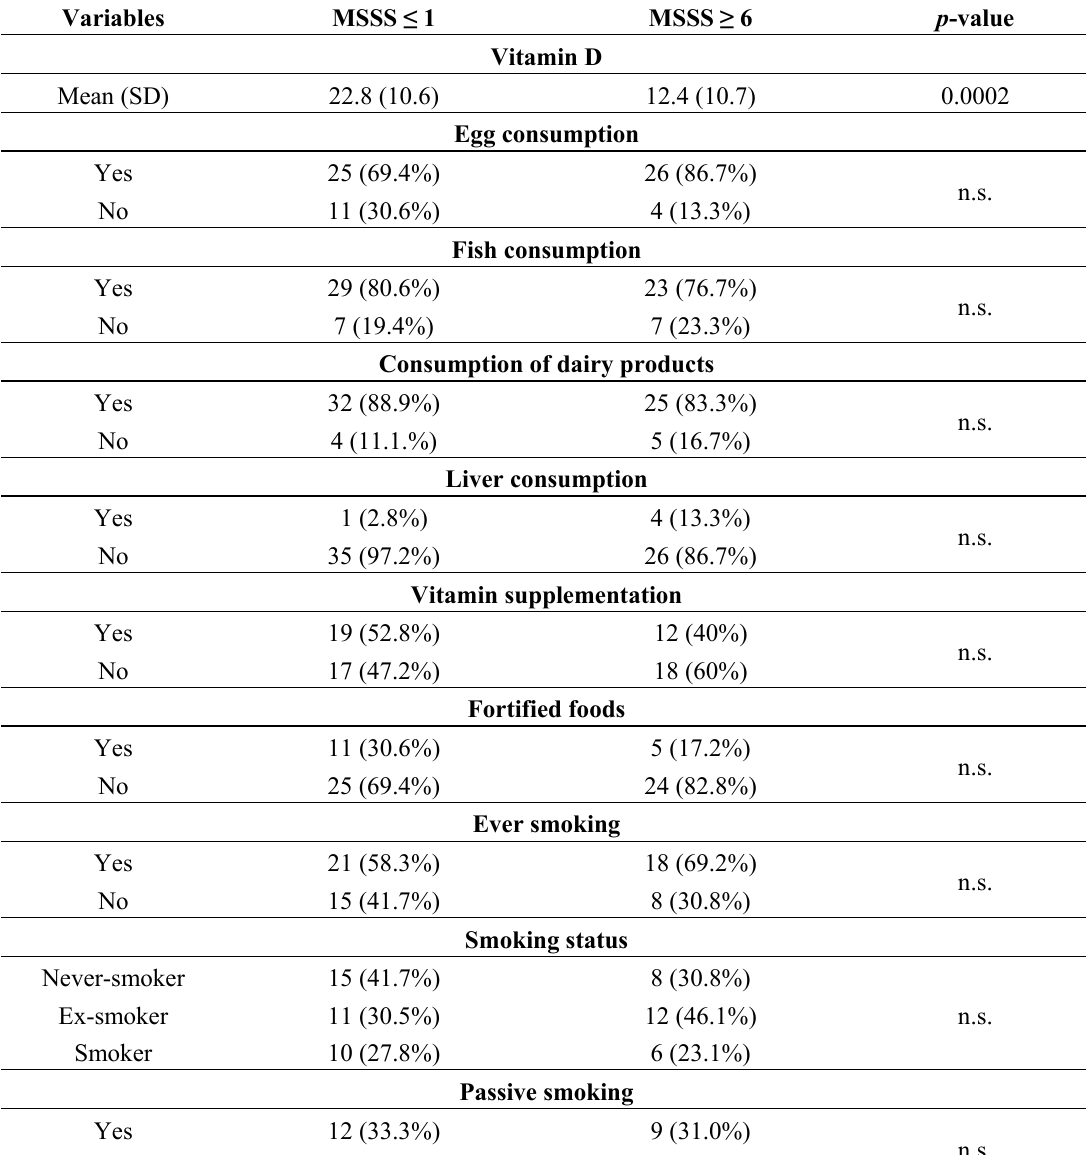
Table 7. Comparison of patients with mild vs. severe MS, according to smoking habits, diet, sunlight